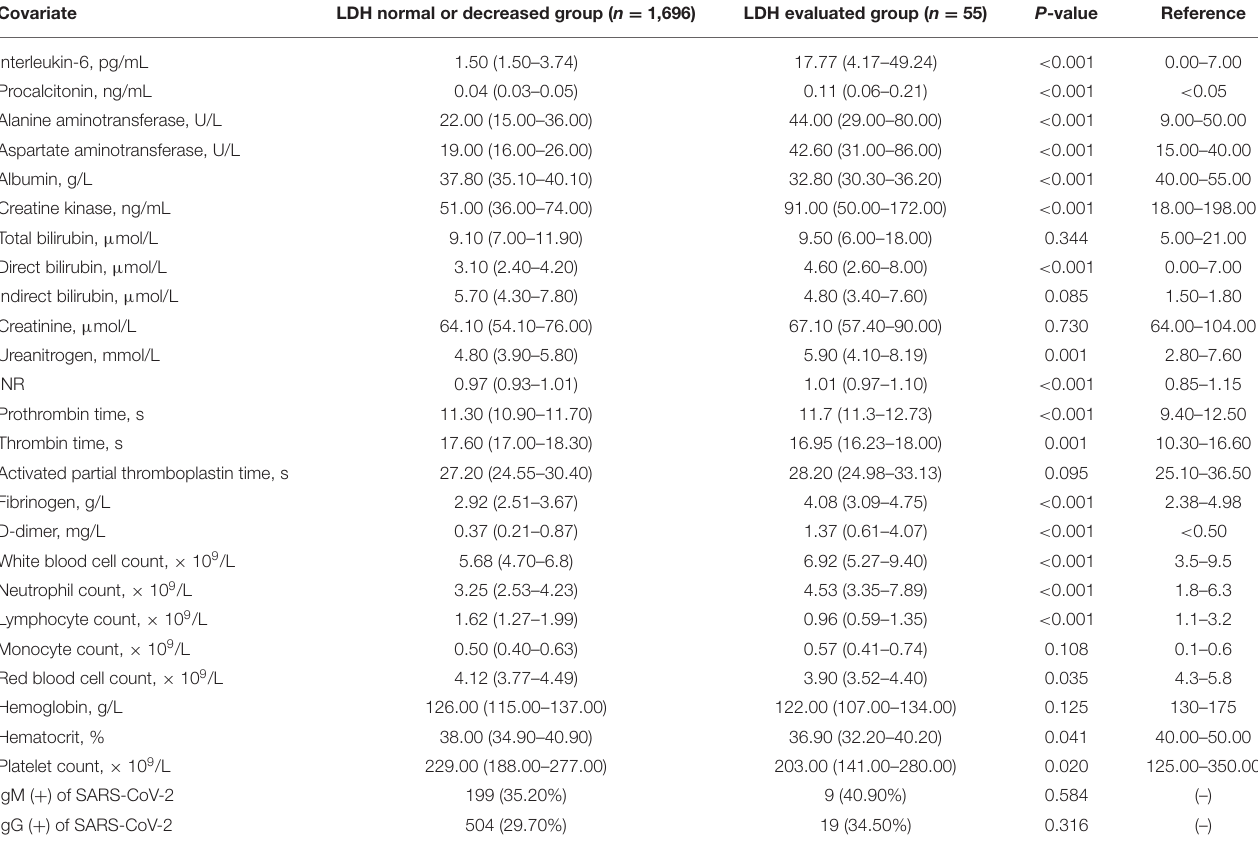
TABLE 2 | Outcomes of laboratory tests for COVID-19 patients in different LDH level. Covariate